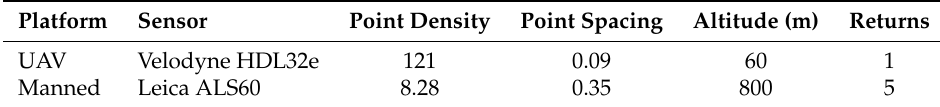
Table 2. Summary of the ALS and UAV-LS datasets used in this